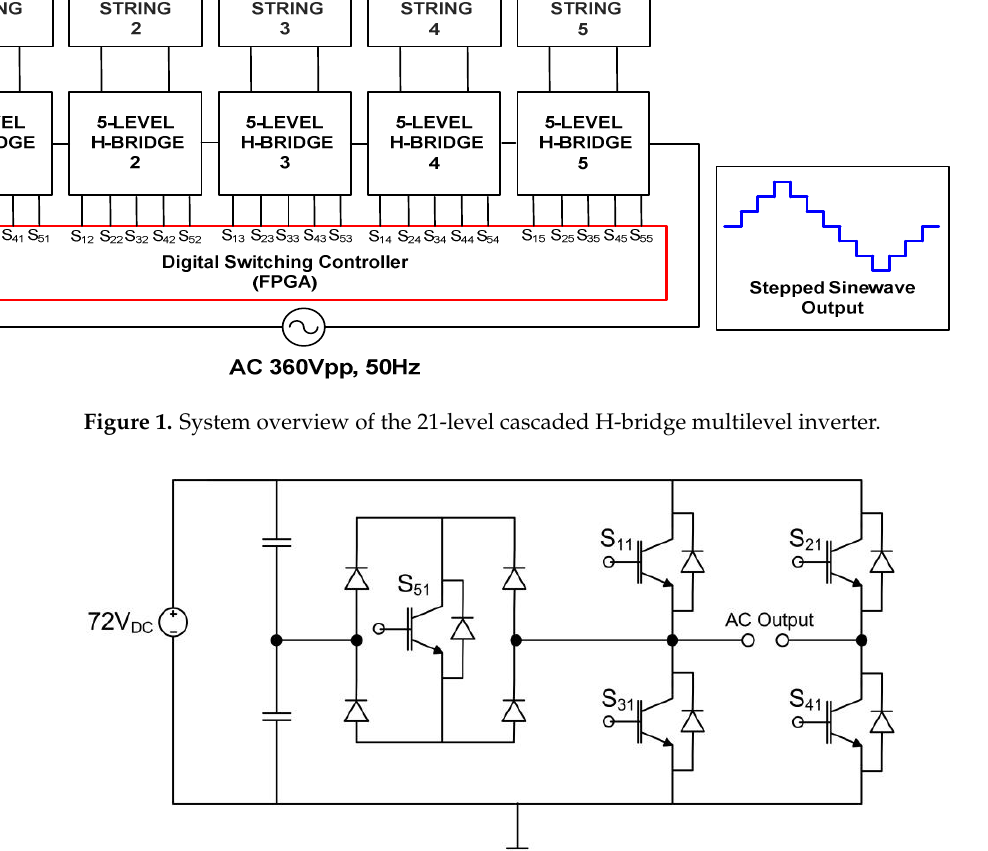
Figure 2. Example of five-level H-Bridge 1 circuit using photovoltaic (PV) string as the DC supply voltage (72 V DC ).